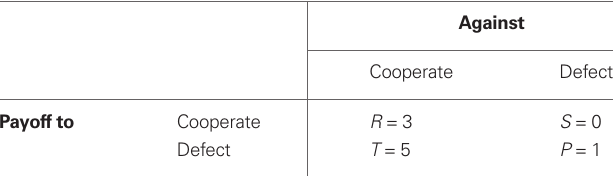
Against Cooperate